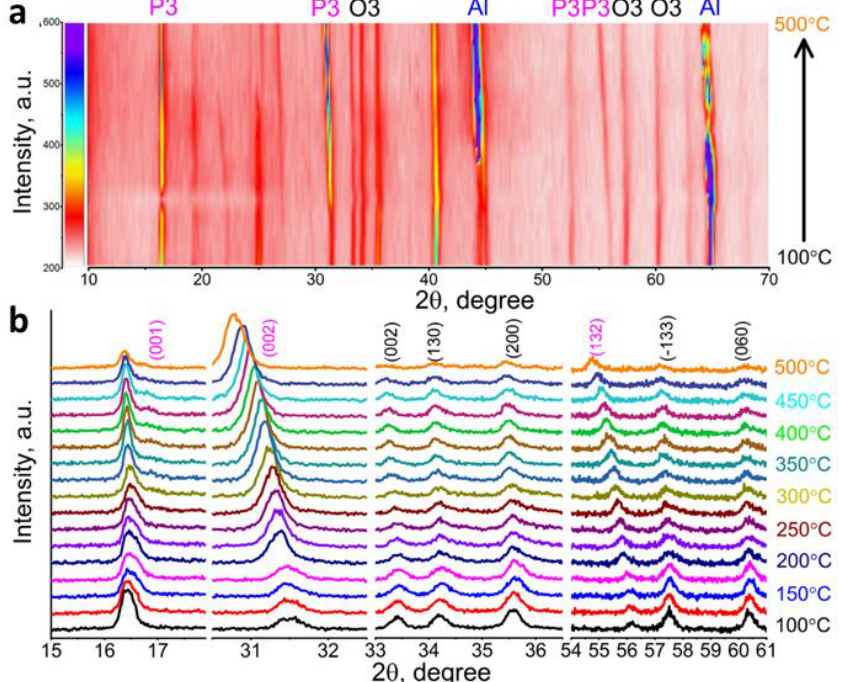
Figure 18. ( a ) Image plots of HTXRD spectra of charged Na x Ni 2/3 Sb 1/3 O 2 heated from 100 to 500 °C. ( b ) The corresponding selected diffraction patterns, peaks labelled pink is P3 phase, and black is O3 [194]; with permission from Elsevier.